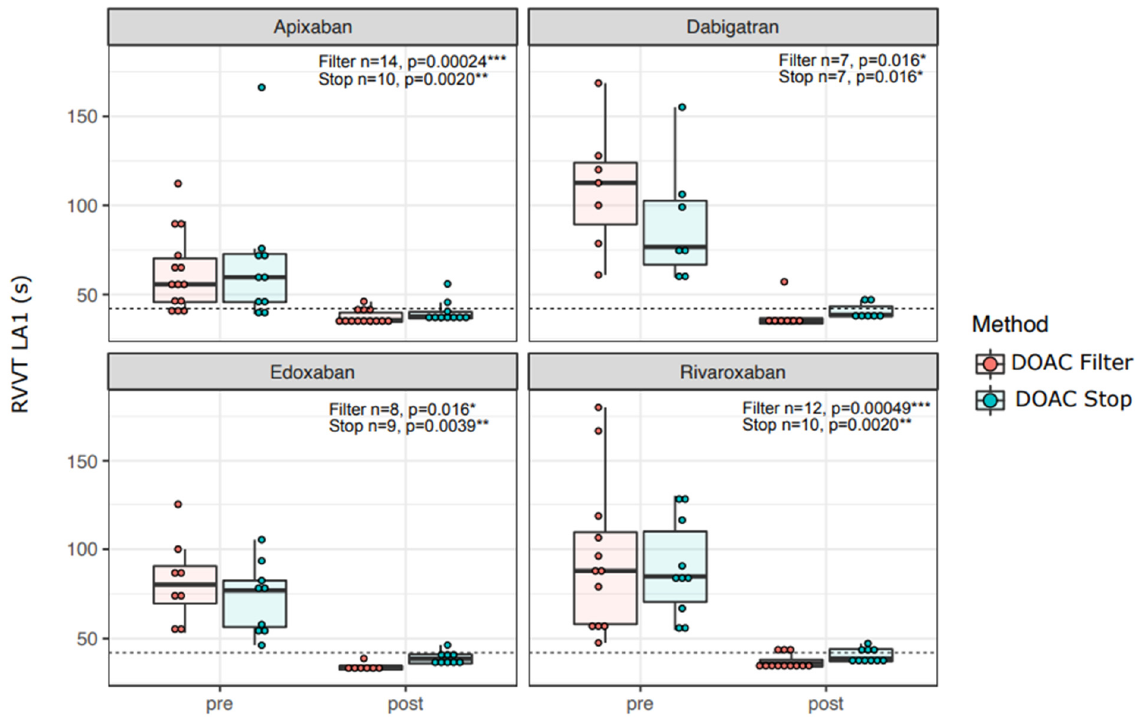
Figure 3. RVVT screening test clotting times reduce with DOAC removal. RVVT- test screening test (LA1) clotting times before and after DOAC Filter ® and Stop™ treatments. The paired sign test was used to test for statistical significance. The dotted line represents the cutoff for a positive screening test (42 s). Asterisks: *: p < 0.05; **: p < 0.01, ***: p < 0.001